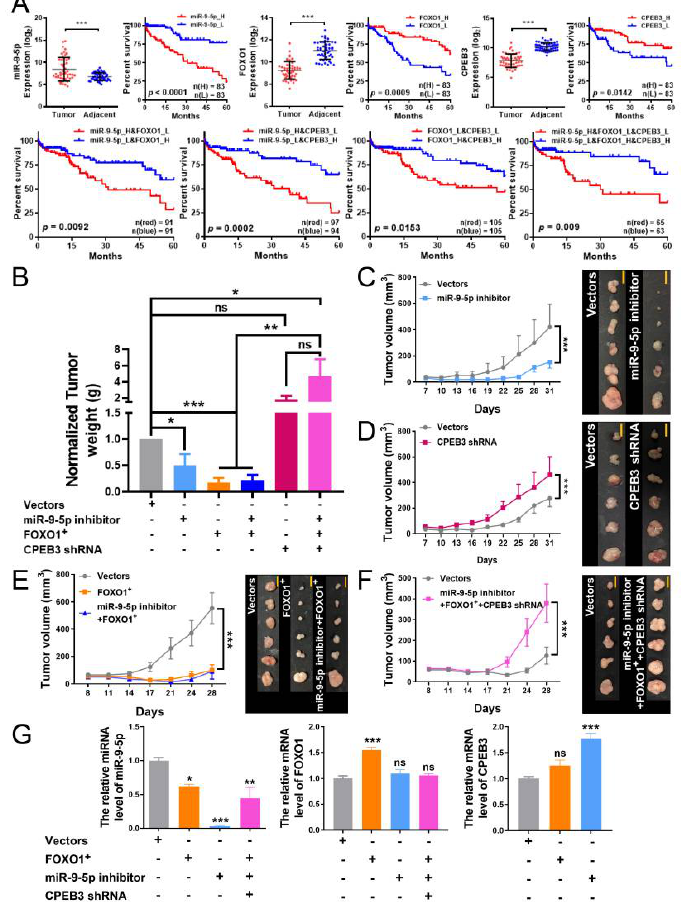
Figure 5. Effects of miR-9-5p/FOXO1/CPEB3 FFL on survival and tumor growth in vivo. ( A ) Box- plots indicate the expression of miR-9-5p, FOXO1 and CPEB3 in TCGA paired HCC and adjacent tissue samples (paired t -test). Kaplan–Meier survival analysis of single genes or combinations of two or three genes in miR-9-5p/FOXO1/CPEB3 FFL at 60 months (log-rank test) in HCC patients. L: Low-expression samples, H: High-expression samples. ( B ) Tumor formation experiment with different treated Bel7402 cells. Tumor weights were detected in the various combinations of miR-9-5p inhibitor/ FOXO1 / CPEB3 -shRNA through tumor hepatoma xenografts. Different combinations have corresponding vectors (blank controls) and all are normalized to 1g as shown in the grey color bar. Normalized tumor weight of treated group is calculated as relative to control (before normalized). Tumor volume of miR-9-5p inhibitor ( C ), CPEB3 shRNA ( D ), FOXO1 or FOXO1 and miR-9-5p inhibitor combination ( E ) and three genes miR-9-5p inhibitor, FOXO1 and CPEB3 shRNA combination ( F ) were periodically measured for each mouse, and growth curves were plotted. Scale bar = 1 cm. Significance test in B was performed with Student’s t -test, others were one-way ANOVA. Mean ± s.e.m., n = 6/group. ( G ) Levels of miR-9-5p (left), FOXO1 (middle), CPEB3 (right) were detected by qRT-PCR in tumor tissues in ( B ). Relative expression levels were calculated for treatment groups compared to the controls (normalized to 1). Non-parametric one-way ANOVA and Dunnett’s multiple comparison post hoc tests. Mean ± s.e.m, n = 3/group. * p < 0.05, ** p < 0.01, *** p < 0.001, ns: